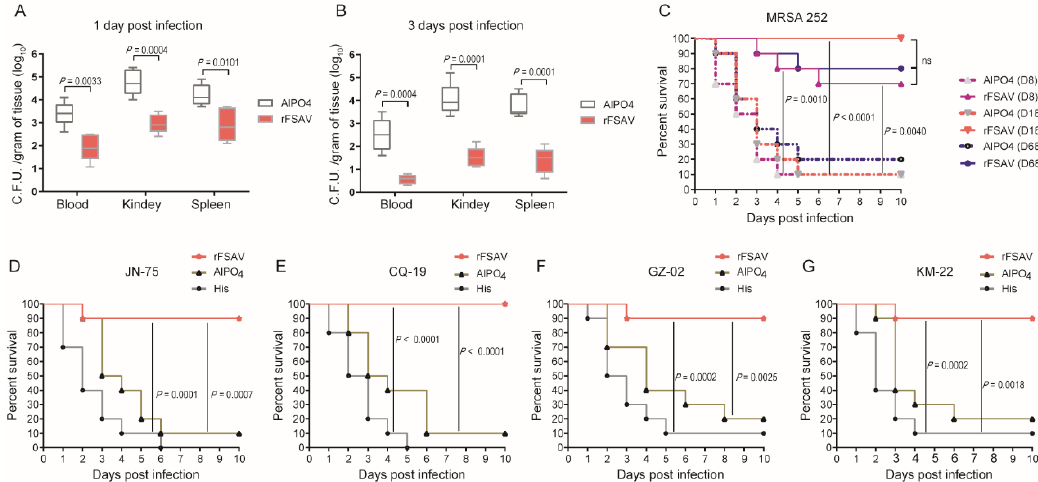
Figure 2. rFSAV stimulates protective immunity in a S. aureus sepsis model. ( A , B ) E ffi cacy of rFSAV on the spread of S. aureus . BALB / c mice ( n = 10) were immunized with rFSAV and challenged with MRSA252 at 3.0 × 10 8 CFUs / mouse by tail intravenous injection. The number of viable bacteria in the blood, kidney and spleen of mice ( n = 10) at 1 and 3 days post-infection were shown. Data were presented in box and whisker plots, and the medians are shown. Di ff erences were compared to determine their significance using Student’s t -test. ( C ) BALB / c mice ( n = 10) were immunized with rFSAV and challenged with MRSA at 6.0 × 10 8 CFUs / mouse on 8, 18 and 68 days post the first immunization by tail intravenous injection. ( D – G ) BALB / c mice ( n = 10) were immunized with rFSAV and challenged with JN-75, CQ-19, GZ-02 and KM-22 (3.0 × 10 8 , 5.0 × 10 8 , 7.0 × 10 8 and 2.0 × 10 8 CFUs / mouse, respectively) on 18 days. ( C – G ) The survival rate was monitored for 10 days. The p -values were calculated using the Mantel-Cox log-rank